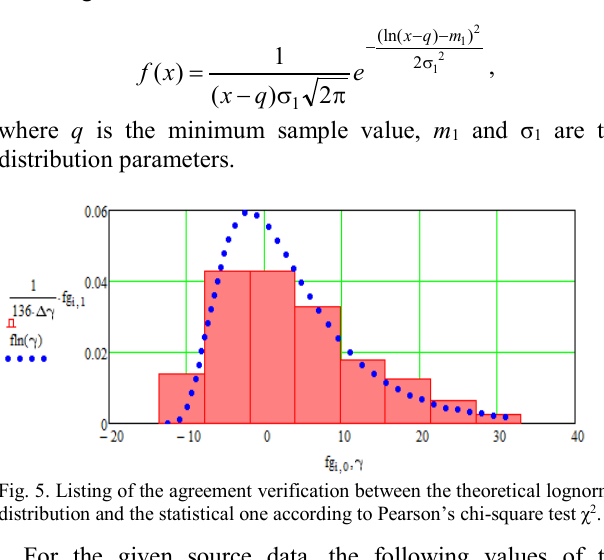
Fig. 6. Agreement verification of Weibull distribution and the statistical one according to Pearson’s chi- square test χ 2